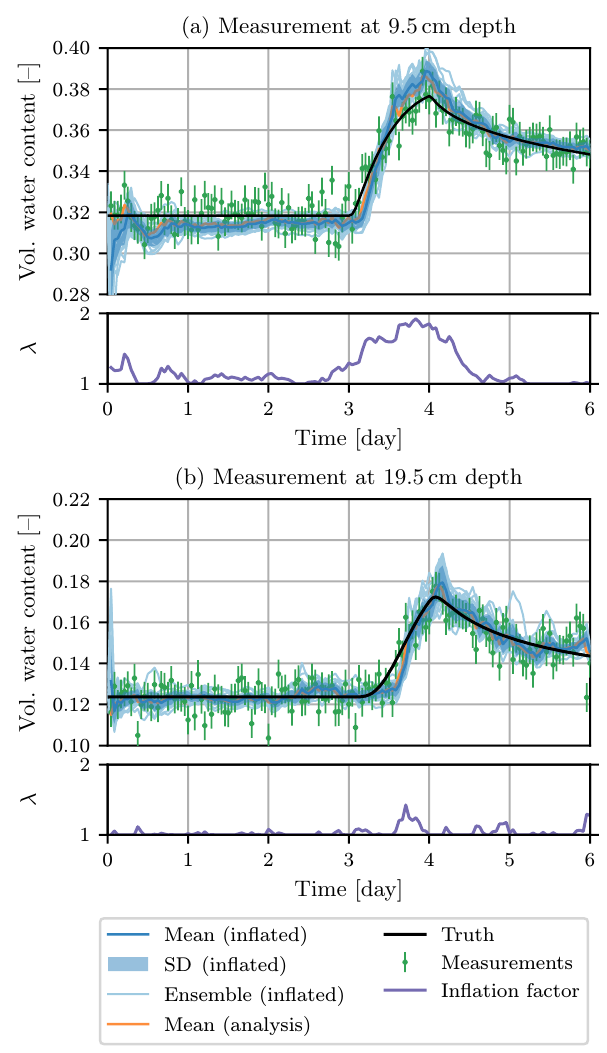
Figure 1. Water content estimation at the two measurement loca- tions. The standard deviation of the inflated ensemble should be able to explain the differences between the inflated mean and the synthetic truth. The inflation factor is increased when the ensemble uncertainty is too